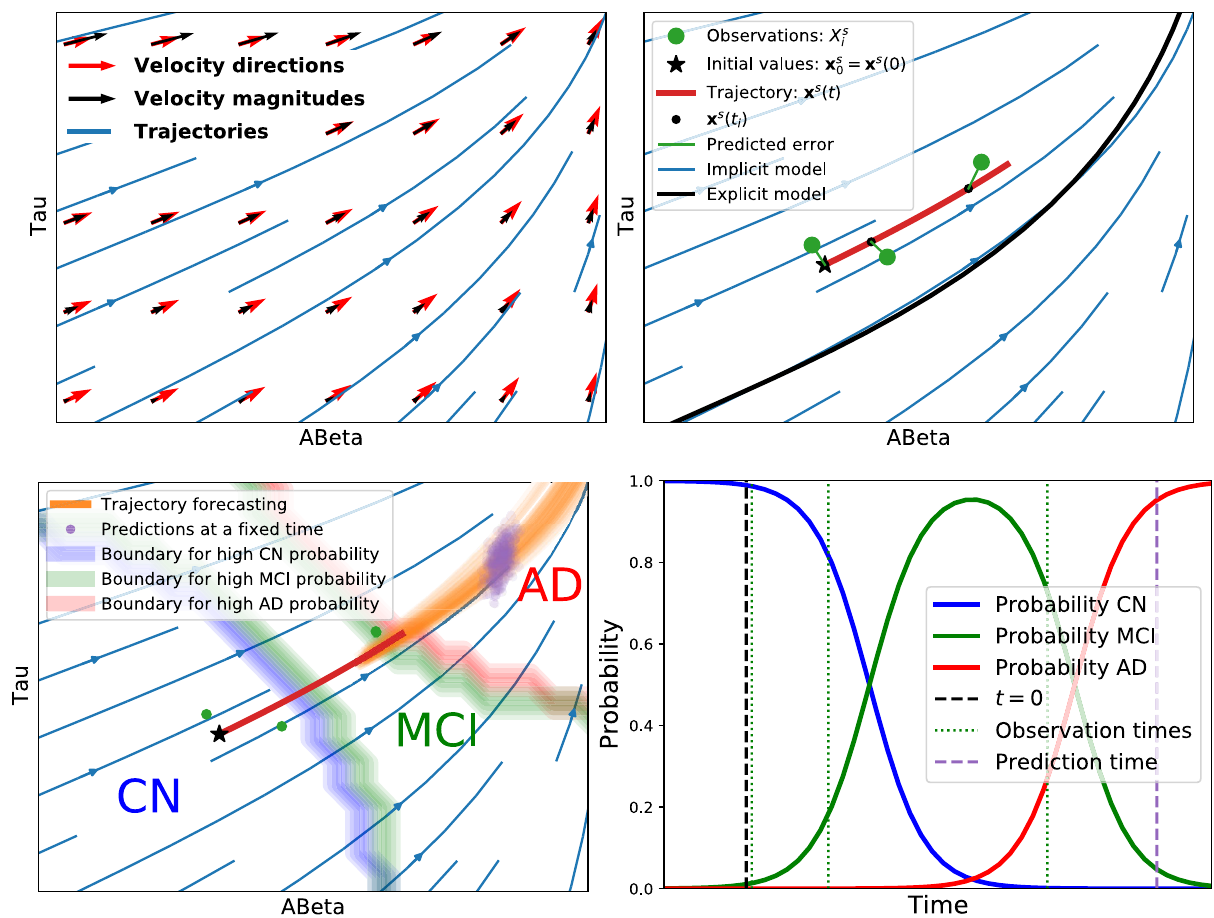
Figure 1. Schematic representation of the proposed framework for AD progression modelling. Top left: A velocity field describes the biomarker evolution at any point in biomarker space. Velocity direction quantifies how each biomarker is changing relative to the others, and velocity magnitude quantifies the mean yearly rate of change. Long-term trajectories are obtained starting at a given point in the biomarker space and evolving with speed equal to the velocity field evaluated at each point. Top right: The modelled trajectories (blue curves) can pass through any point in the biomarker space, contrary to explicit models that describe one-dimensional trajectories (black curve). Individual predictions are obtained by fitting the most probable subject trajectory (red curve), i.e. the closest trajectory to the observations (green dots) at the correct time points. Only the initial value (black star) needs to be estimated. Then the trajectory is computed according to the velocity field. The initial value estimation has no serious identifiability issues because it should be close to the observations at the corresponding reference time, the left-most green dot in this case, regardless of the velocity field estimation. On the contrary, explicit models estimate the time-to-onset or an equivalent parameter that locates the individual’s trajectory on the black curve. These two parameters (mean trajectory and individuals’ time-to-onset) are highly correlated, giving rise to identifiability issues. Bottom left: A clinical prediction model assigns a clinical label probability for any combination of biomarkers and covariates. For a fixed set of covariates, these probabilities can be visualised as a heat map. The figure in this panel illustrates the boundaries where the most likely label changes, from Cognitively Normal in the bottom left extreme (normal levels in both biomarkers) to Dementia in the top right extreme (abnormal levels in both biomarkers). These boundaries depend on the subject covariate values. Therefore, they are located at different places for each person. The subject trajectory can be forecasted following the velocity field (orange curves). The purple dots represent the predicted biomarker levels at a fixed time after the last observation, along with their uncertainty. We can estimate future clinical outcomes using these forecasted values as input to the clinical prediction model. Bottom right: Probability for each clinical label along the predicted subject trajectory as a function of time. Vertical lines denote the initial time (black), observation times (green) and the selected time for prediction given by the purple dots in the bottom left panel (purple). Note that in the biomarker space representations (the top panels and the bottom left panel), there is no explicit indication of the speed at which the biomarker space is being travelled and of predicted diagnosis label change in time. The length of trajectory segments at different regions of the biomarker space is not indicative of the relative times needed to traverse